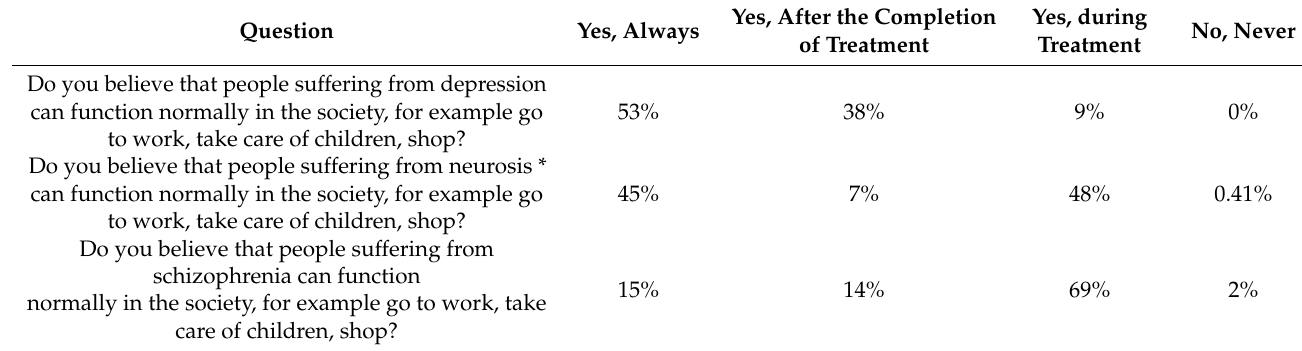
Table 3. Distribution of answers regarding the ability to function in the society.